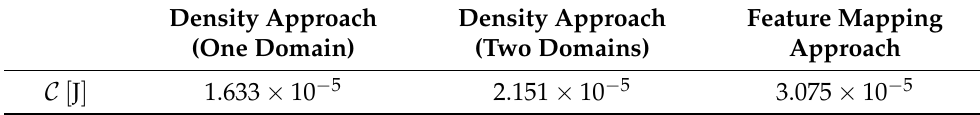
Table 4. Resulting compliance values from the three presented